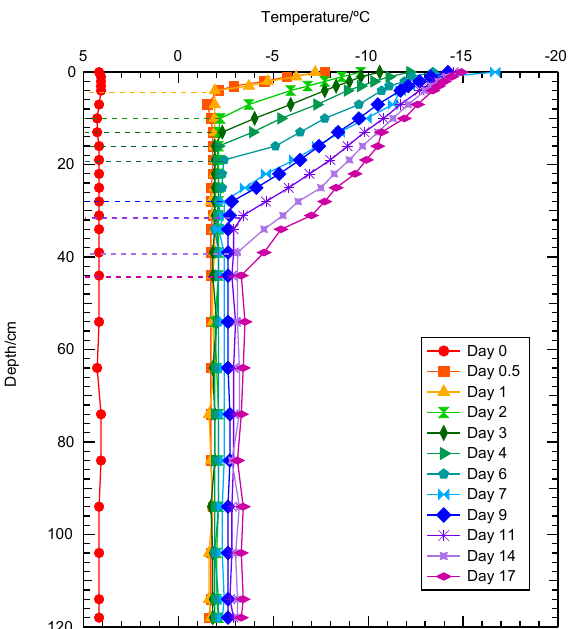
Figure 2. Temperature profiles through ice during ice growth. The top section, showing a linear increase in temperature, represents measurements from the ice, while the bottom section, with a con- stant temperature, shows measurements from the under-ice seawa- ter, demonstrating that the water is not thermally